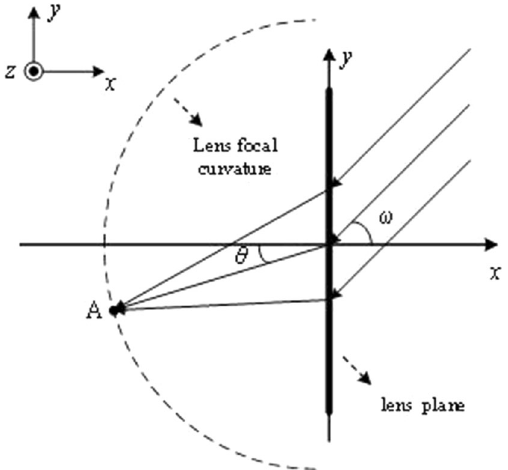
Fig. 2 Block diagram of a wideband mmWave massive MIMO-OFDM system with a lens antenna